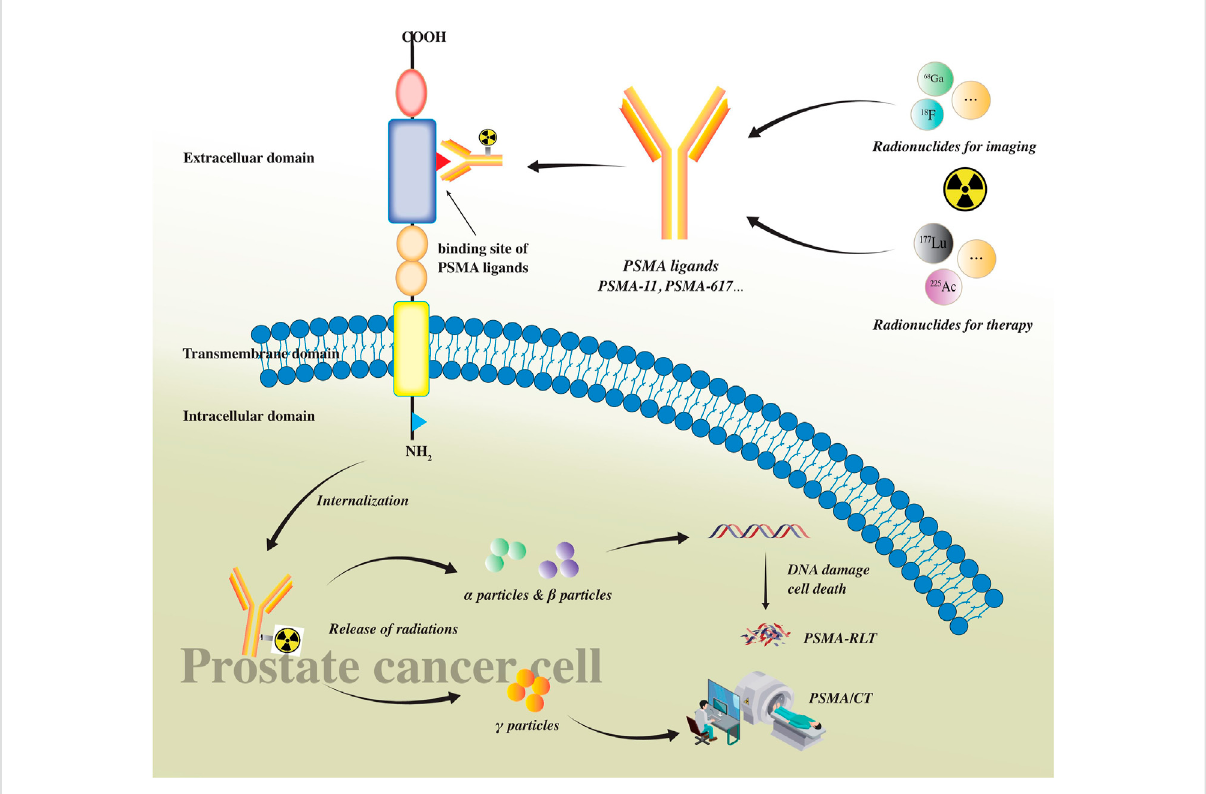
FIGURE 1 PSMAasatransmembraneglycoproteinconsistsofthreeparts:intracellular,transmembrane,andextracellulardomain.Thereisaligandbinding siteintheextracellulardomainwhereligandsbindwithPSMAonprostatecancercells.PSMAligands(suchasPSMA-11andPSMA-617)canbelabeled with radionuclides for imaging (such as 68 Ga and 18 F) and/or therapy (such as 177 Lu and 225 Ac). After radiolabeled PSMA ligands bind with the extracellular ligand binding site of PSMA, they would be internalized into prostate cancer cells, releasing different particles. Alpha( α ) and beta( β ) particlescancauseDNAdamageleadingtocancercelldeathandbeusedinPSMA RLT.Gamma( γ )particlescanbedetectedusingPETscansandbe used in PET/CT